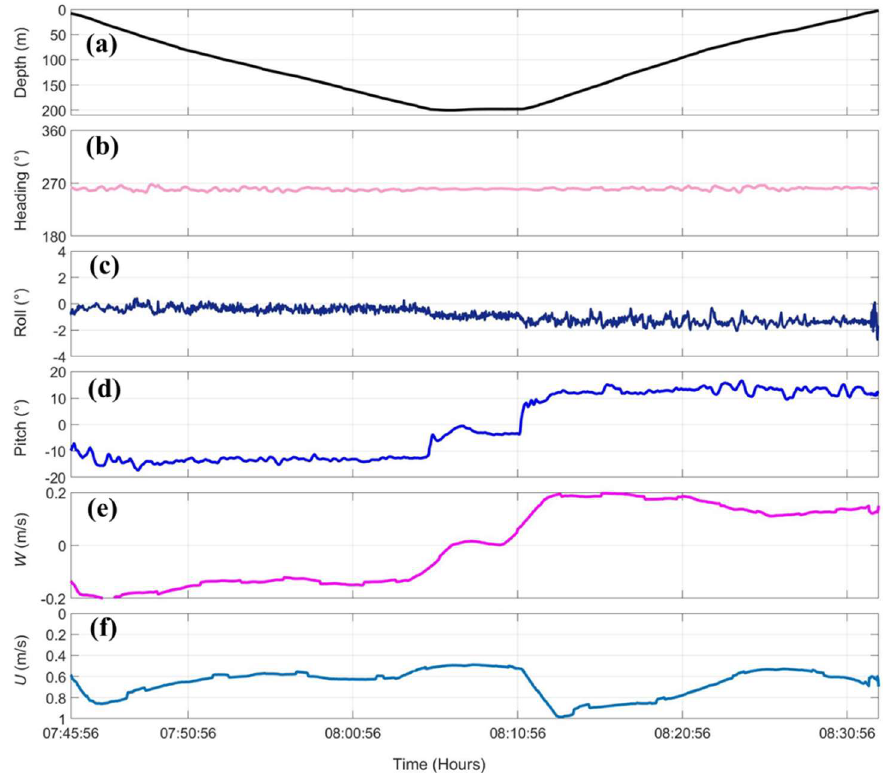
Figure 7. Sea-Whale 2000 AUV (with the CPMTM) flight performance parameters of one profile. Time series are shown for ( a ) depth, ( b ) heading, ( c ) roll, ( d ) pitch, ( e ) vertical speed ( W ), and ( f ) speed along the AUV path ( U ).